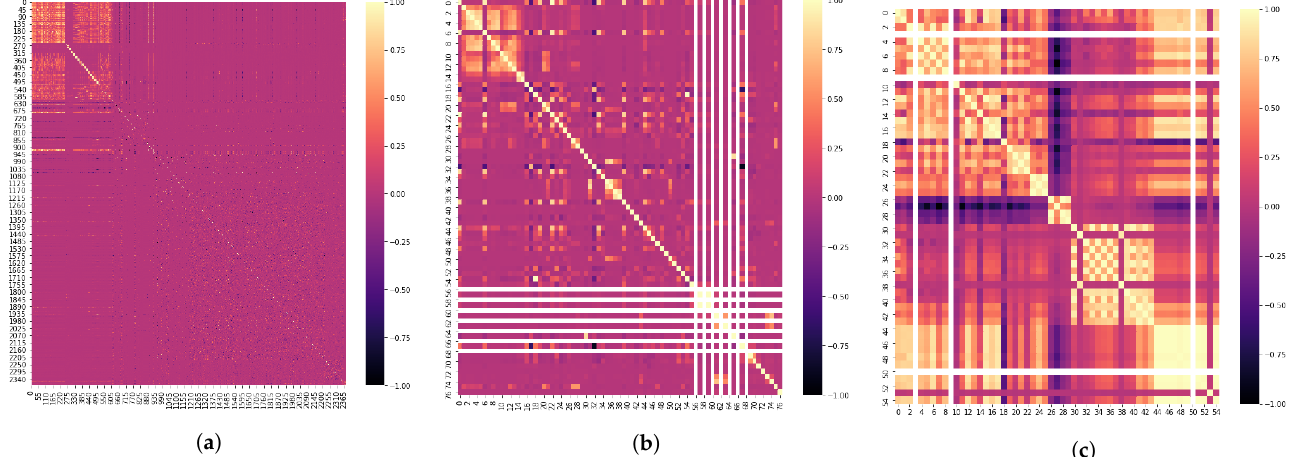
Figure 2. Feature correlation analysis of each malware dataset: ( a ) BODMAS, ( b ) Kaggle, and ( c )